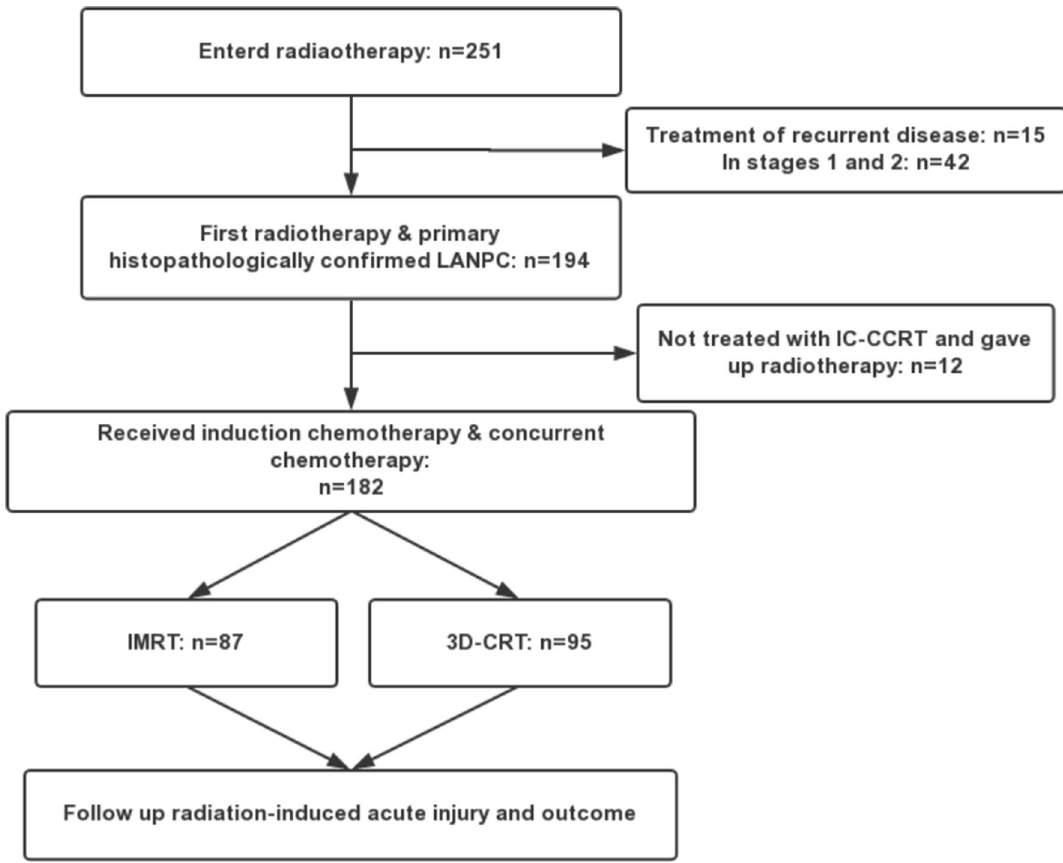
Figure 2. The consolidated standards of reporting trials (CONSORT) flow-chart for the